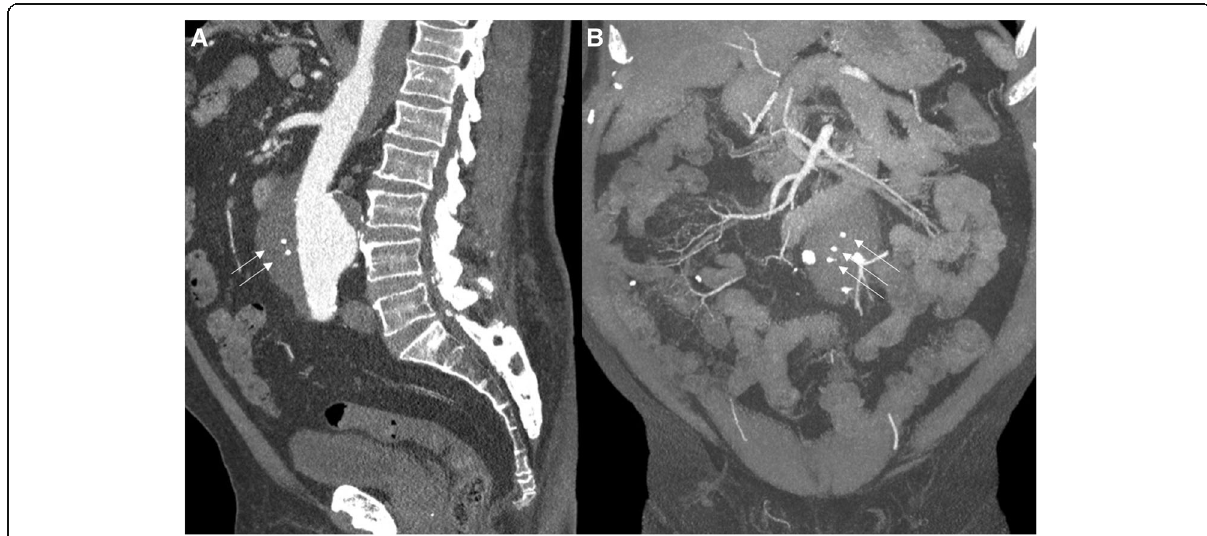
Fig. 4 Maximum intension projection (MIP) reconstructions in the sagittal ( a ) and coronal ( b ) plane of the first post-procedural CT angiography showing markers of the plugs